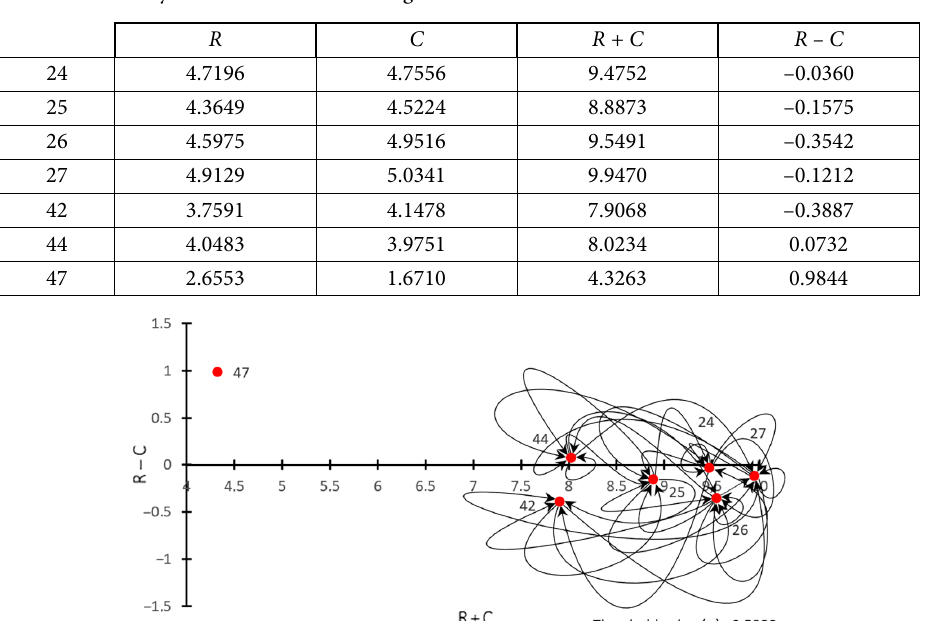
Table 18. Auxiliary calculations for C2 Management / Human Resources